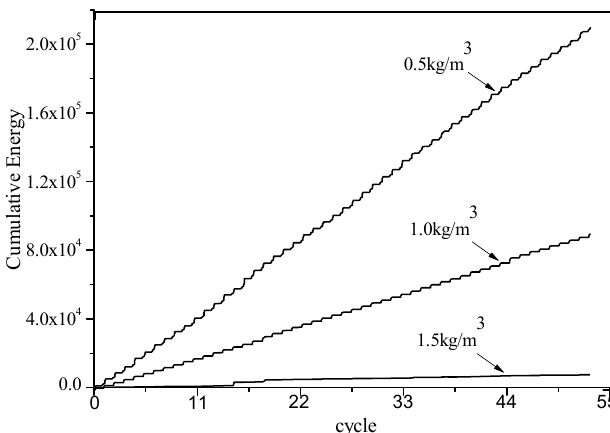
Figure 4. AE cumulative energy vs . time.